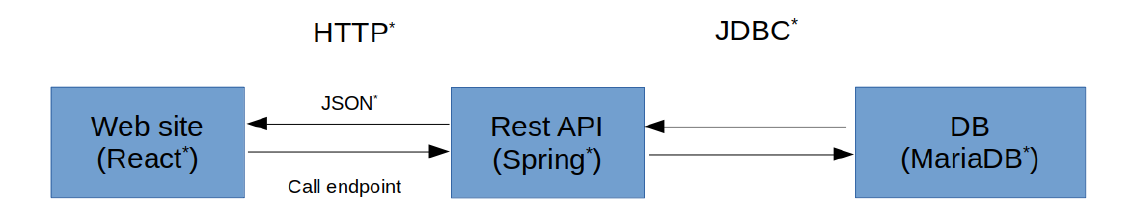
Figure 2. Organisation of a BASECOL instance. The terms labeled with an asterisk are found in the Abbreviation and Glossary